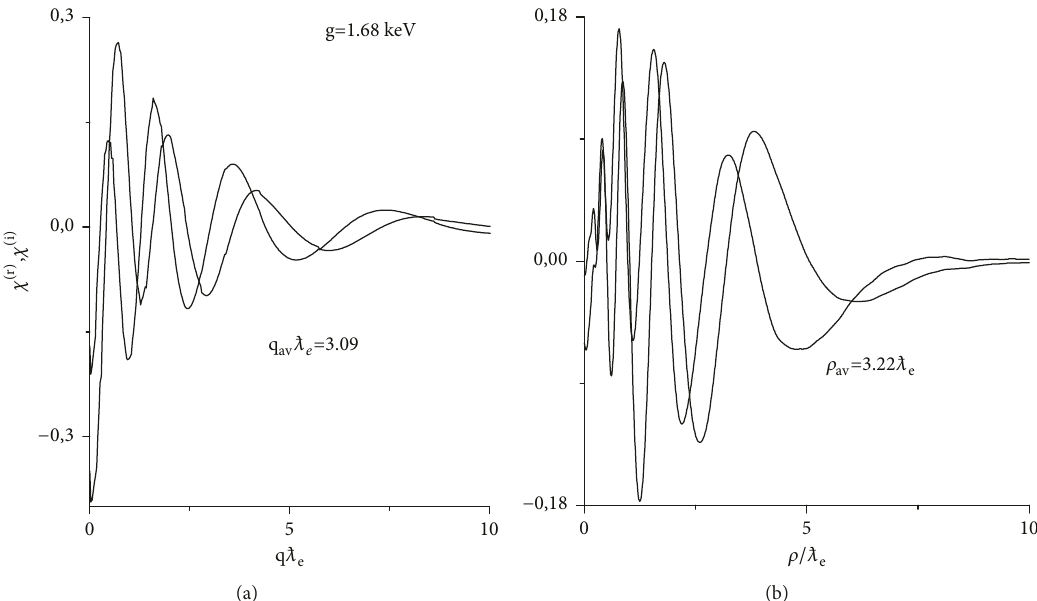
Figure 3: The same as in Figure 2 except for the massless boson energy equal to 1.68keV. The parameter 𝑓 0 = 130 .